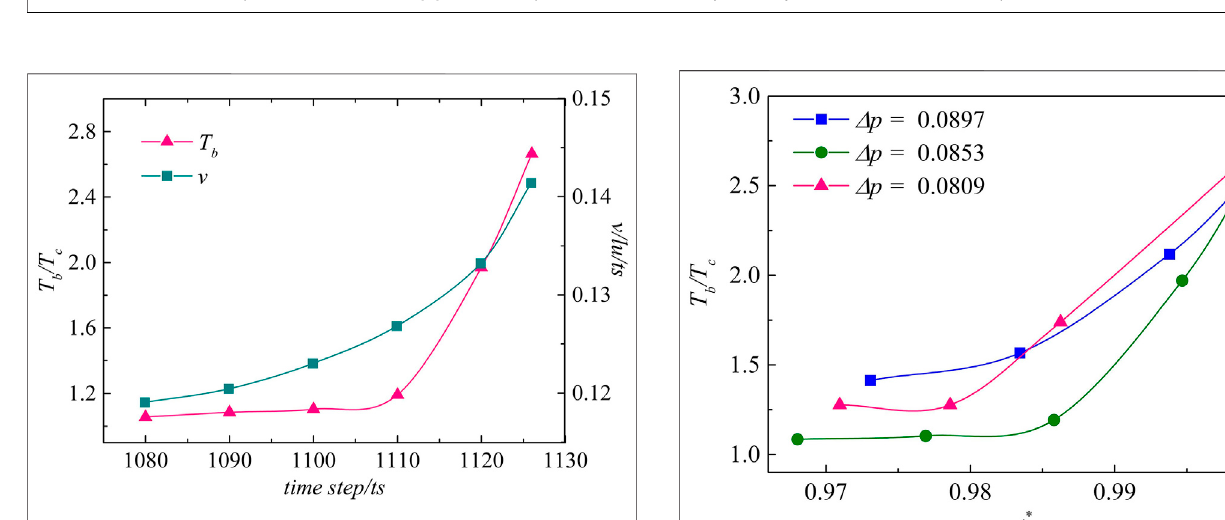
FIGURE 9 | (A) Bubble temperature and maximum jet velocity vs. time for different offset parameters at λ = 1.2; (B) Bubble temperature and maximum jet velocity vs. time for different offset parameters at λ = 1.4; (C) Bubble temperature and maximum jet velocity vs. time for different offset parameters at λ = 1.6.